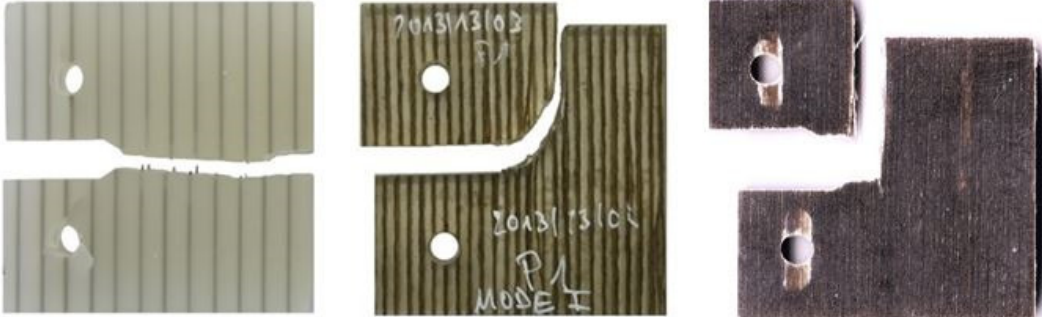
Figure 6: Compact tension specimens with different fibre volume fractions (0° fibre